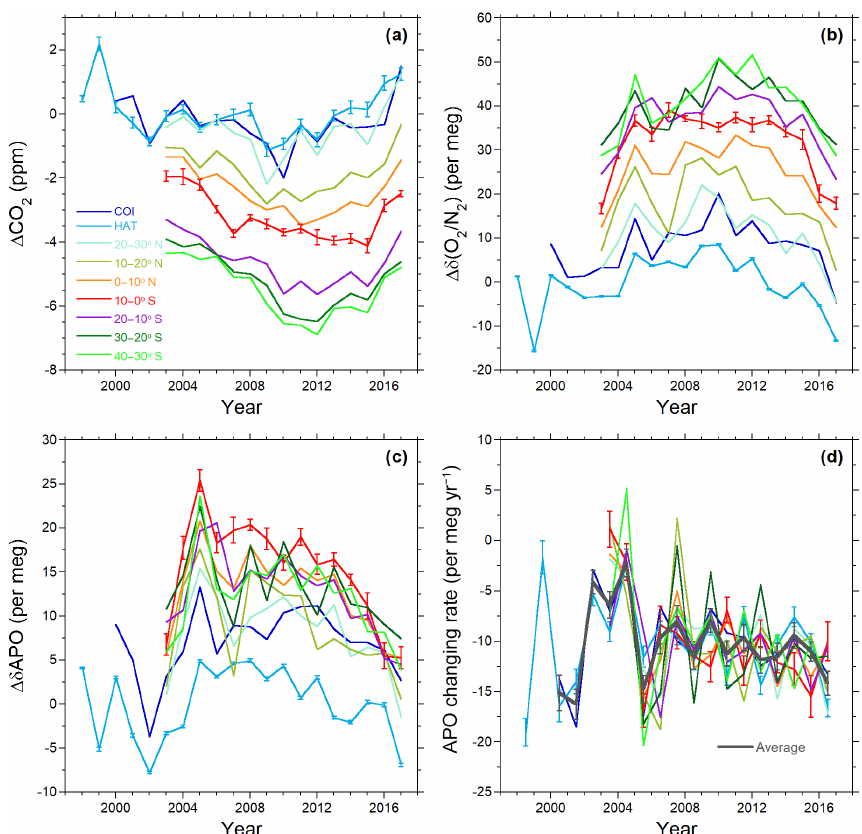
Figure 6. Temporal variations of the (a) annual mean CO 2 , (b) annual mean O 2 / N 2 , (c) annual mean APO and (d) annual changing rate of APO based on the flask samples collected from HAT, COI and cargo ships in the western Pacific (40 ◦ S–30 ◦ N). The differences in the annual means from the linear trends fitted to the data at HAT are depicted in the figures to emphasize the interannual variations. Vertical bars for the plots of HAT and 10–0 ◦ S bin correspond to the standard errors of the annual